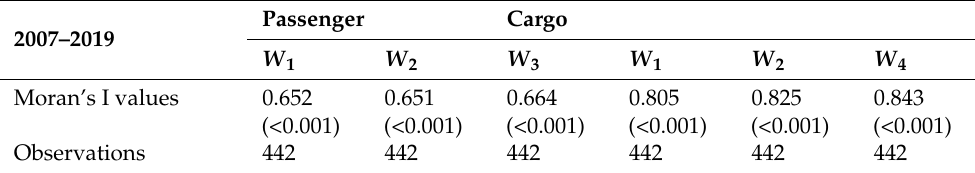
Table 2. Panel of the global Moran’s I values of passenger and cargo